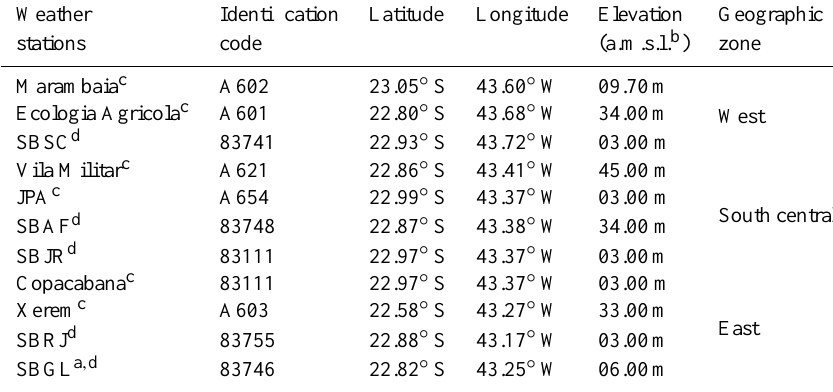
Table 1. Location of the surface and a upper-air weather observation stations. b a.m.s.l.: above mean sea level. Weather Identification